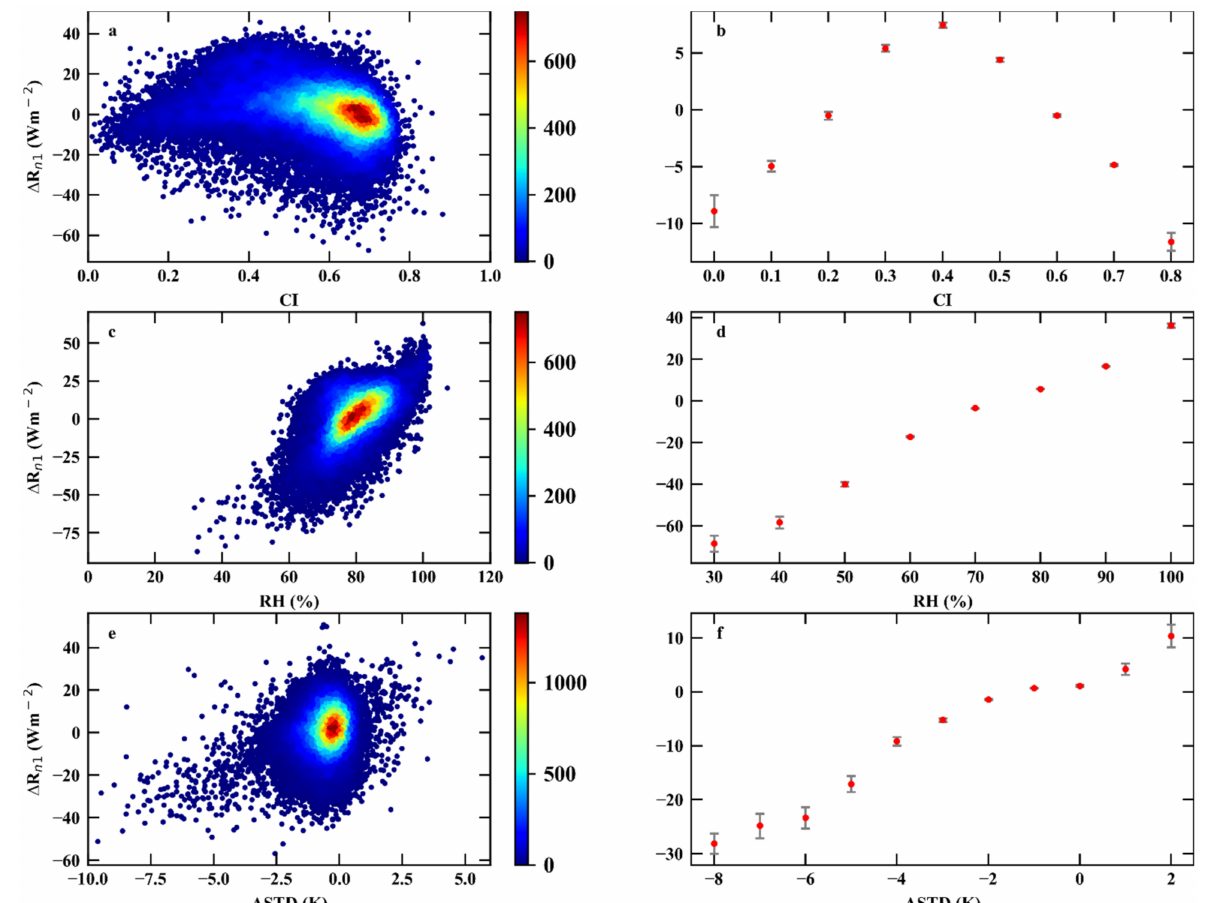
Figure 4. The scatter plots showing relationships between the model residuals ∆ R n1 from Equation (12) and ( a ) CI, ( c ) RH and ( e ) ASTD, and ( b ), ( d ) and ( f ) are their corresponding box plots.